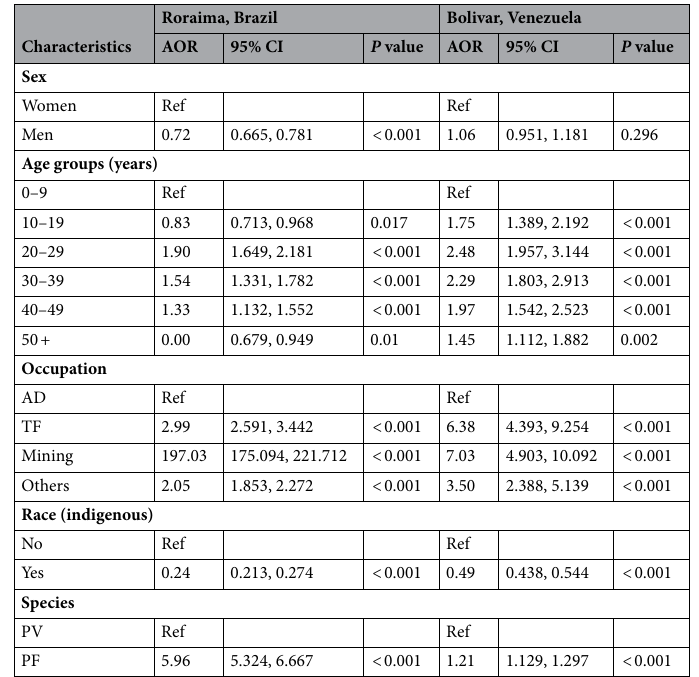
Table 2. Multivariable logistic regression of imported malaria in Roraima, Brazil and Bolivar, Venezuela: 2016–2018. Ref reference group, PV Plasmodium vivax , PF Plasmodium falciparum. AOR adjusted odds ratio, CI confidence interval, p-value < 0.05. AD agriculture and domestic, TF tourism, fishing and timber, Others other